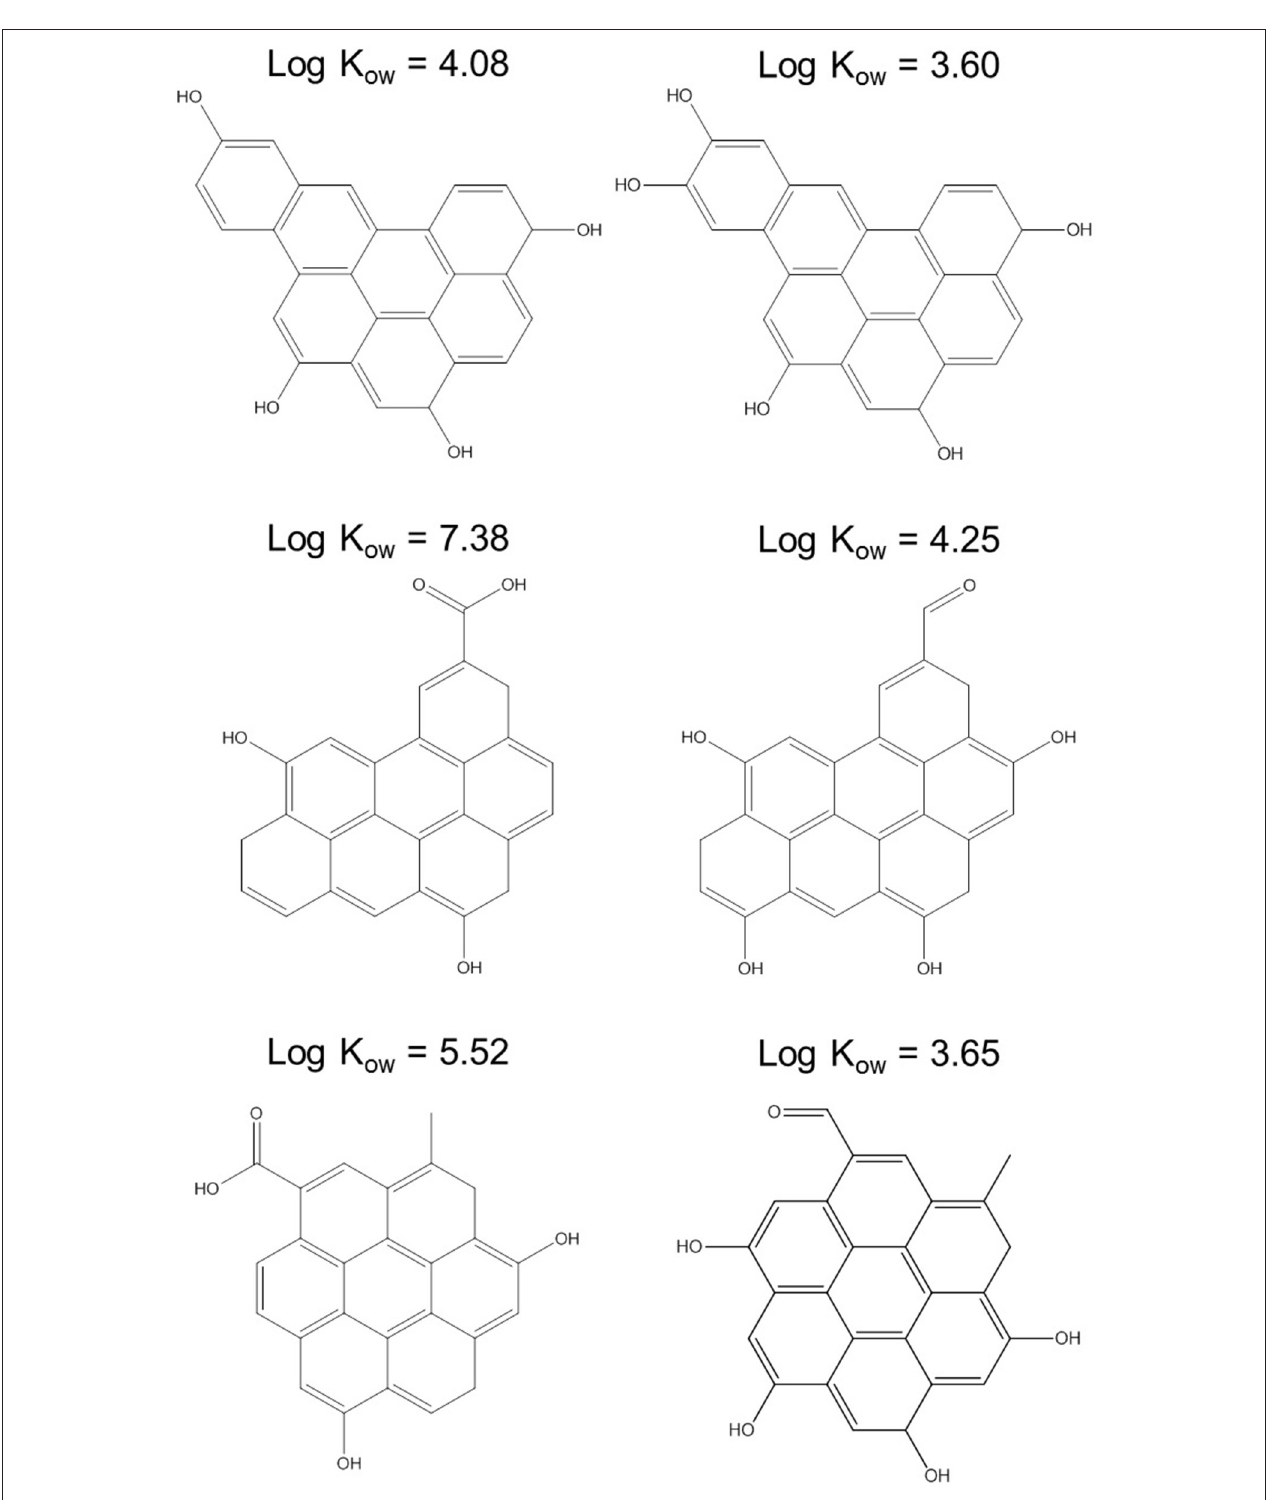
FIGURE 1 | A selection of proposed DBC molecular structures and modeled log K ow values.